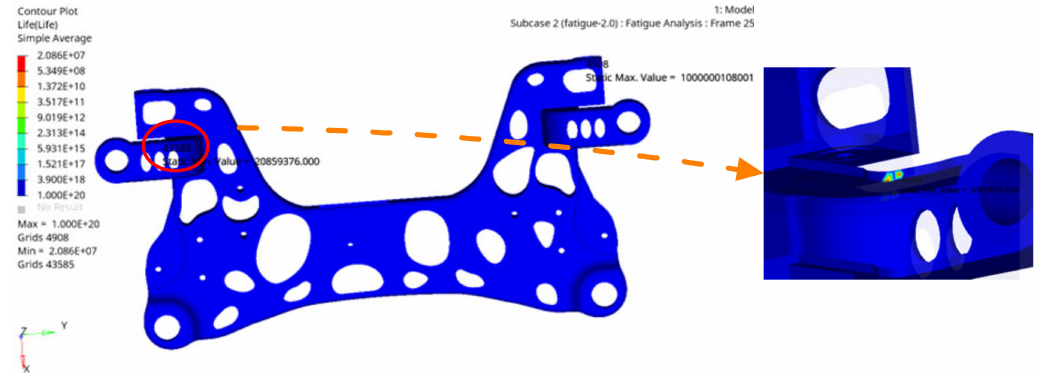
Figure 20. Fatigue life cloud diagram of aluminium alloy front subframe over one side deep pit